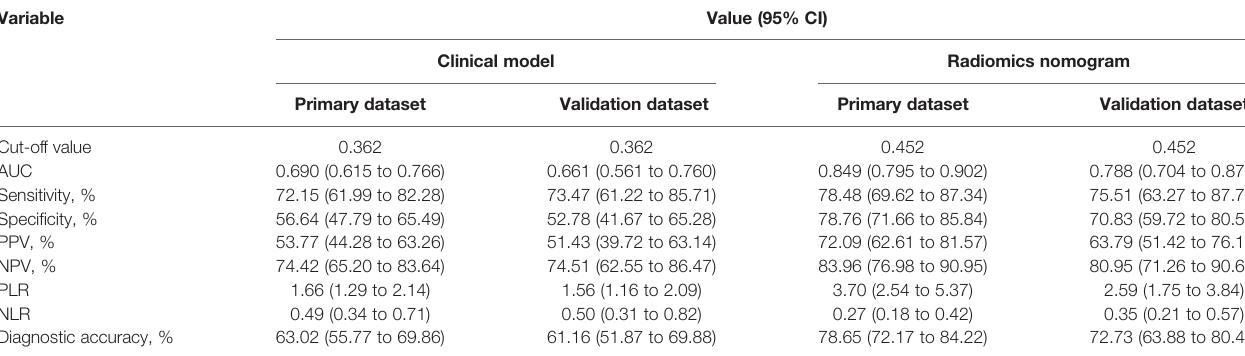
TABLE 4 | Performance of the radiomics nomogram and clinical model for evaluating the preoperative MVI status.